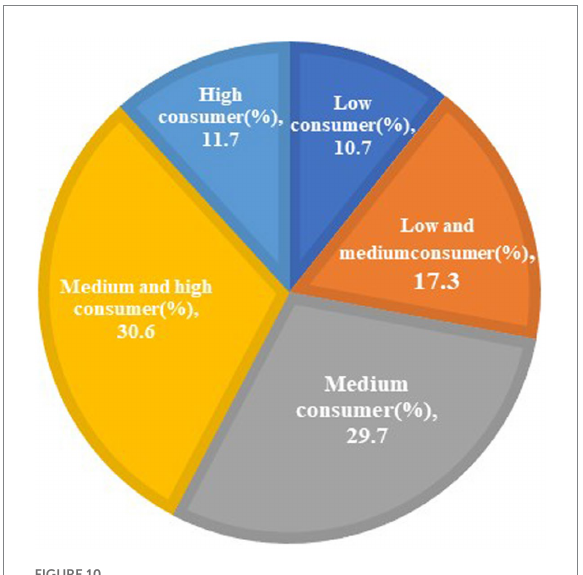
FIGURE 10 Analysis on the consumption ability of Spring Rain Doctor’s